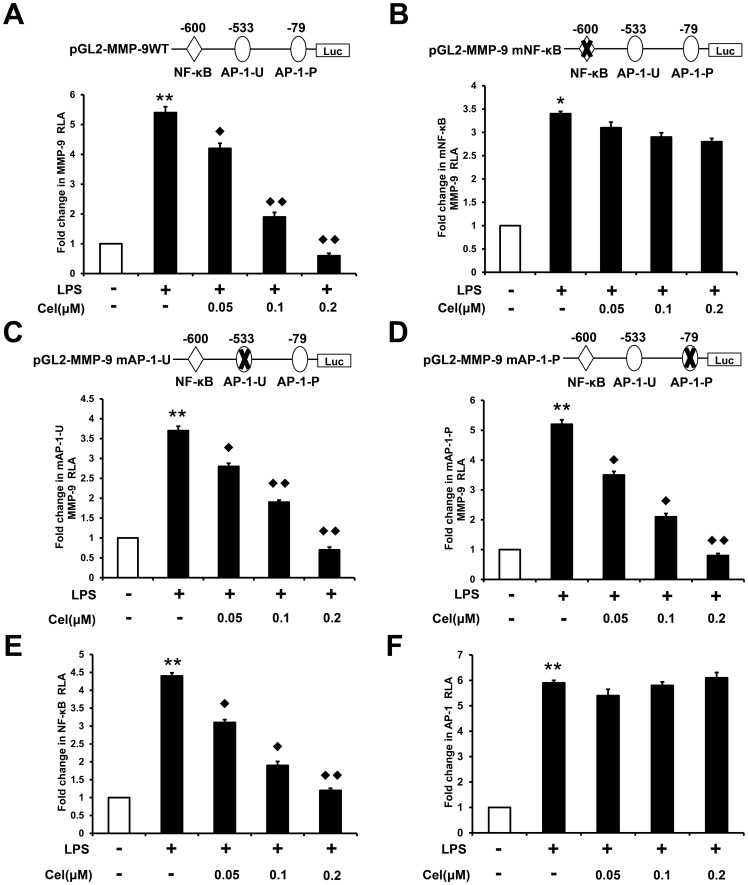
Celastrol inhibits the transcriptional activity of MMP-9 by suppression of LPS stimulated NF-κB activity.
A: RA-FLSs were transfected with pGL2-MMP-9WT and Renilla luciferase reporter vector plasmids. The transfected cells were treated with the indicated concentrations of celastrol and/or LPS for 24 h. The relative luciferase activity in the cell extract was normalized to Renilla luciferase activity. Each value represents the mean ± SD of triplicate experiments and is expressed relative to the control. B, C and D: FLSs were transfected with pGL2-MMP-9 mNF-κB, pGL2-MMP-9 mAP-1-U and pGL2-MMP-9 mAP-1-P. The transfected cells were treated with the indicated concentrations of celastrol and/or LPS for 24 h. The relative luciferase activity is normalized to Renilla luciferase activity and is expressed relative to the controls. E and F: FLSs were transfected with reporter plasmids containing tandem elements for NF-κB or AP-1 binding sites. After 24 h, cells were treated with or without 1 µg/mL of LPS for 24 h and the luciferase activities were determined. *
P<0.05, **
P<0.01 versus normal control group, ⧫
P<0.05, ⧫⧫
P<0.01 versus LPS alone-treated group.